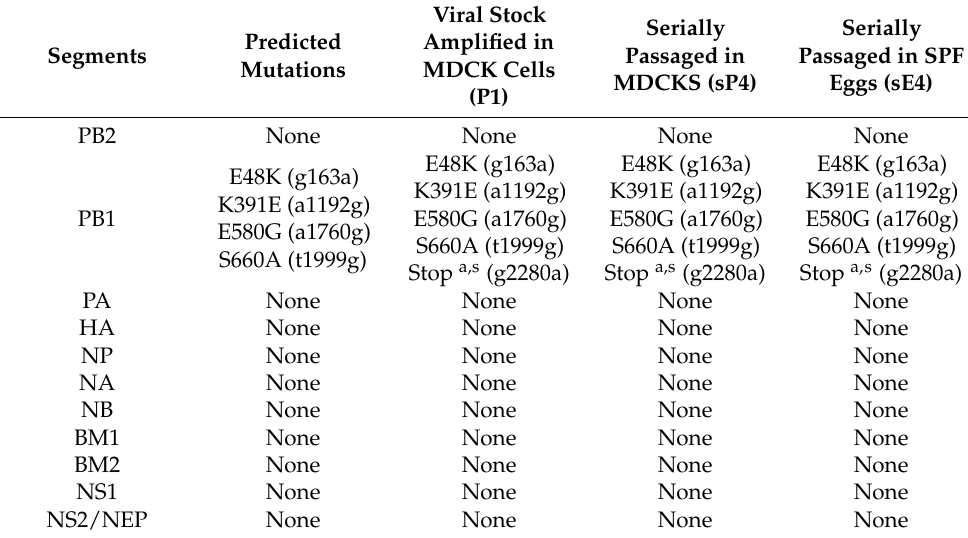
Table 2. Amino acid substitutions in all gene segments of B/Bris PB1att 4M after serial passage. Predicted mutations indicate mutations introduced into the PB1 segment via site-directed mutagenesis and reverse genetics.